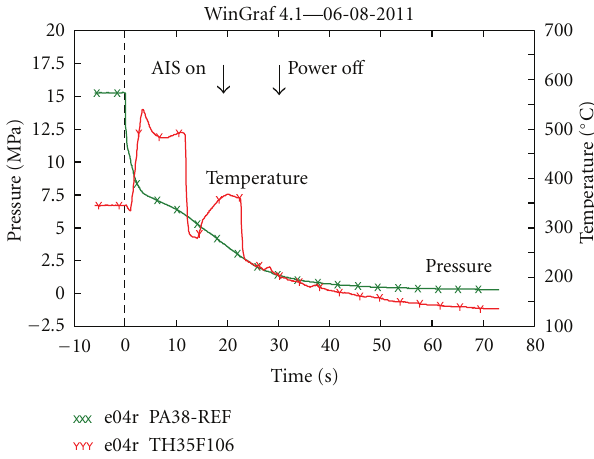
Figure 3: Primary system pressure and heater rod temperature res- ponse to a large 200% cold leg break LOCA (Downcomer gap width